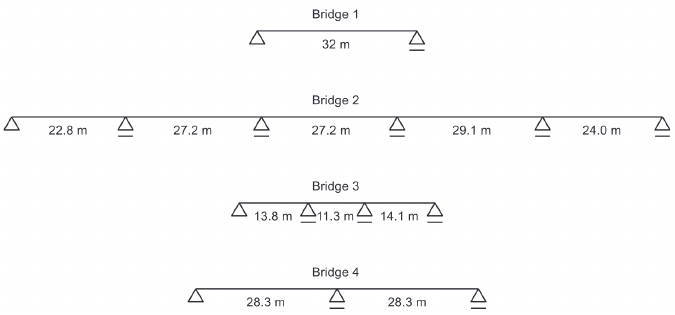
Figure 5. Span lengths of the case study bridges